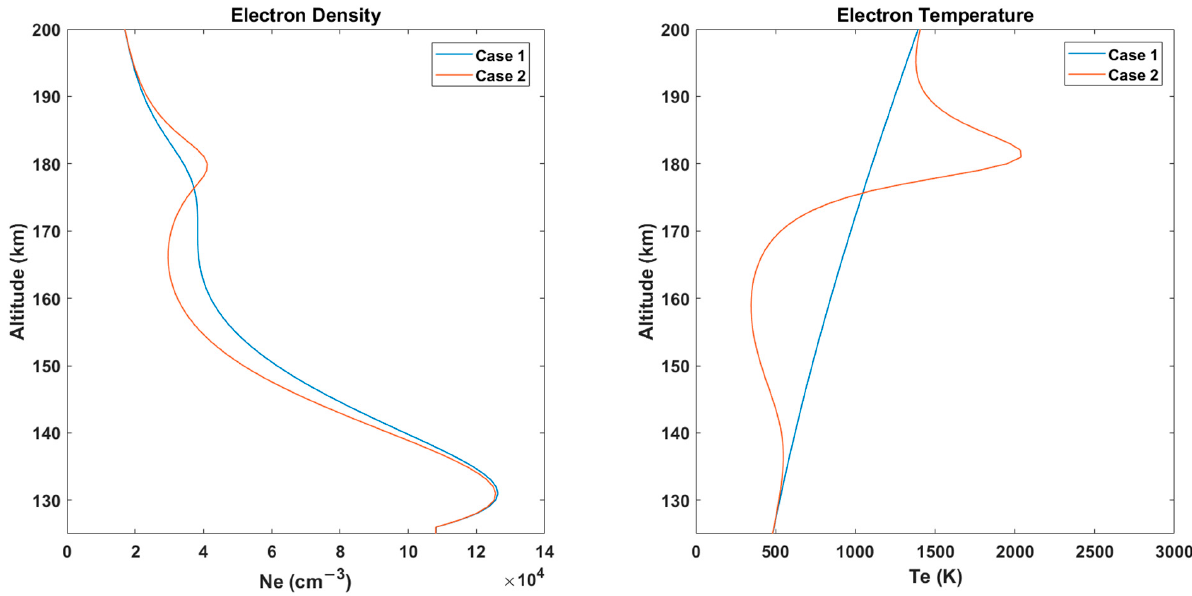
Figure 5. Variations in electron density ( left ) and temperature ( right ) in Cases 1 and 2 at a running time of t = 1000 s.